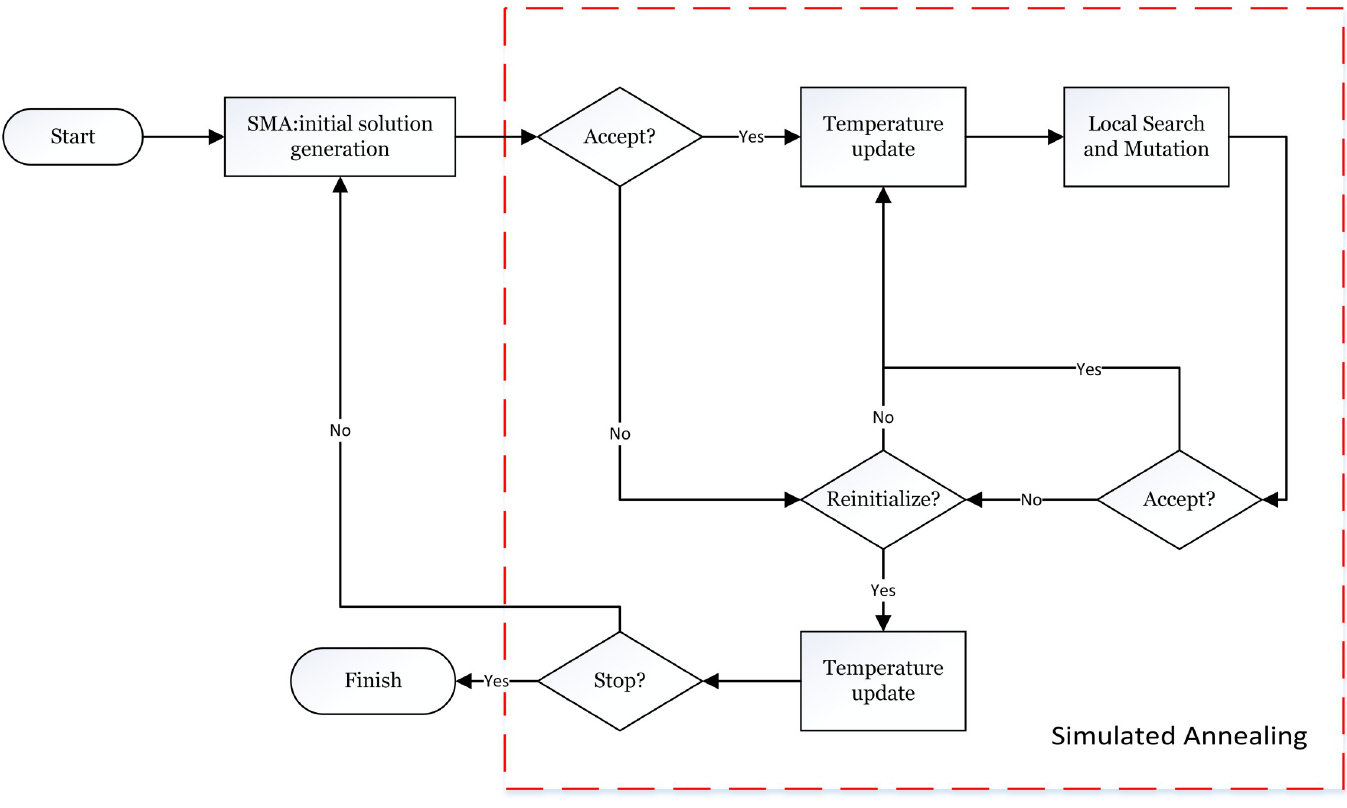
Fig 5. Flowchart of SMA-CSA for CVRP.